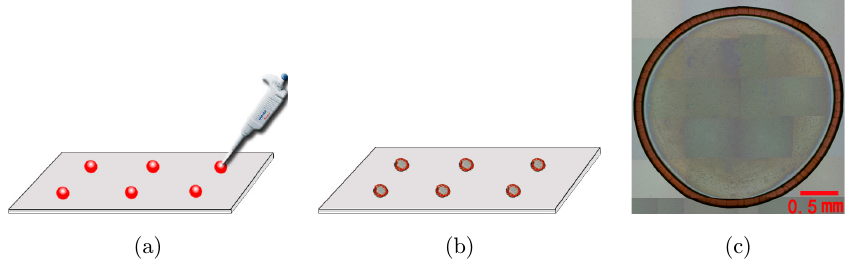
Fig. 1. Schematic of hemoglobin samples preparation for Raman measurement. (a) A 5- (cid:2) l drop of Hb sample was transferred onto a rectangle aluminum plate, respectively, then (b) the drop was left in the air for drying naturally. (c) Composite photograph showing the drop coating ring pattern produced by air-drying Hb sample solution on a rectangle aluminum